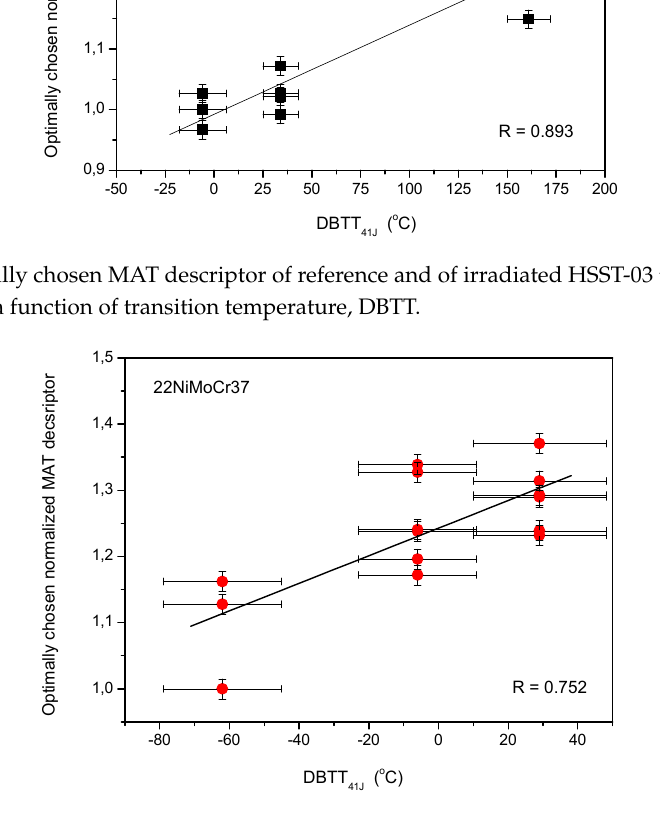
Figure 6. Optimally chosen MAT descriptor of reference and of irradiated 22NiMoCr37 type reactor steel material as a function of transition temperature, DBTT.